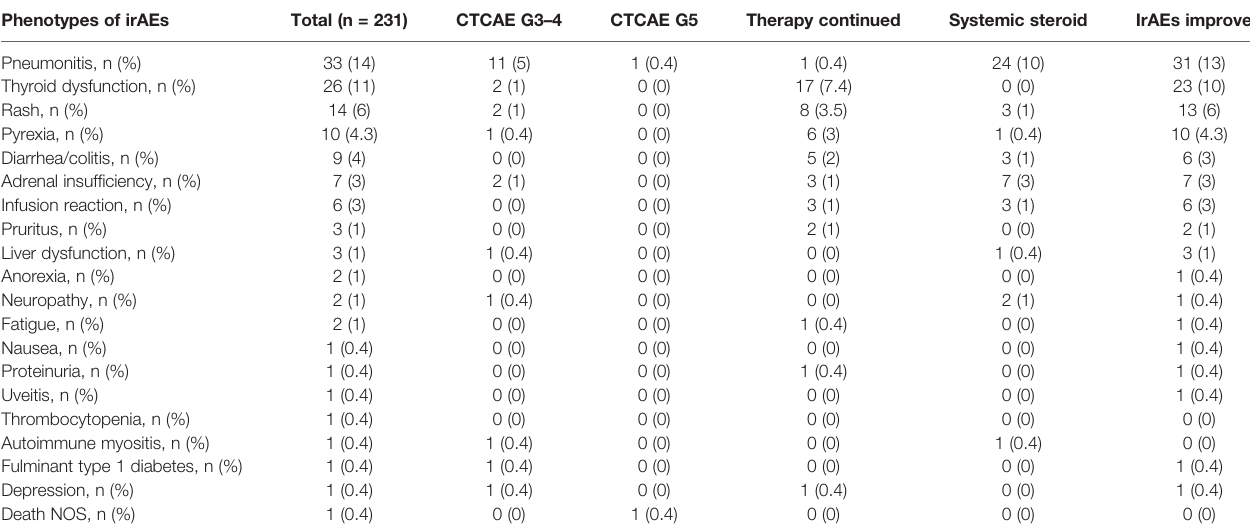
TABLE 2 | Distribution of